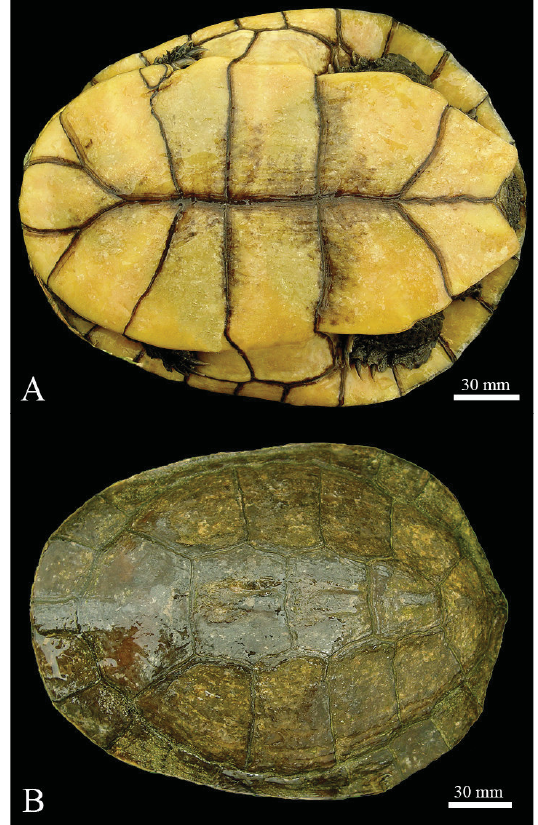
Figure 2. Mesoclemmys tuberculata , ventral (A) and dorsal (B)